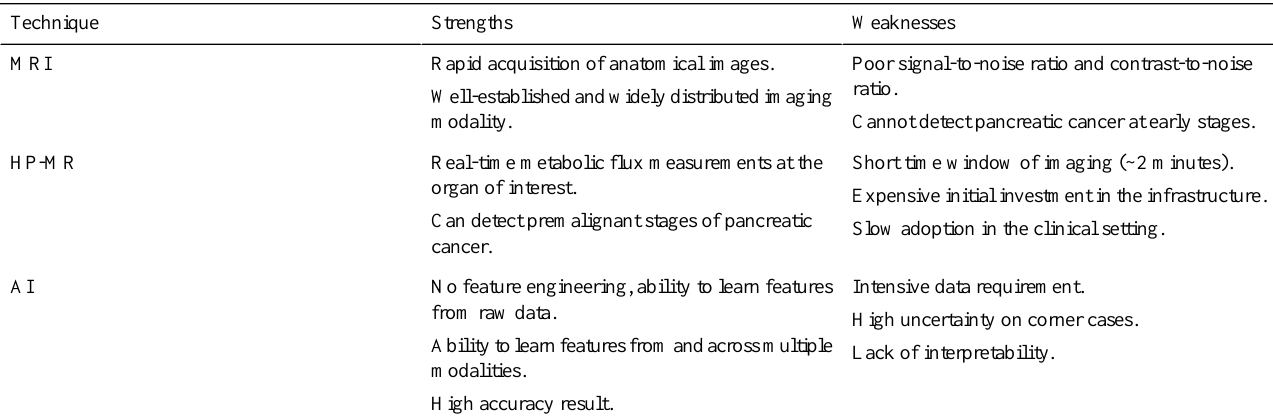
Table 4. Strengths and weaknesses of artificial intelligence (AI), magnetic resonance imaging (MRI), and hyperpolarized magnetic resonance (HP-MR). WeaknessesStrengthsTechnique